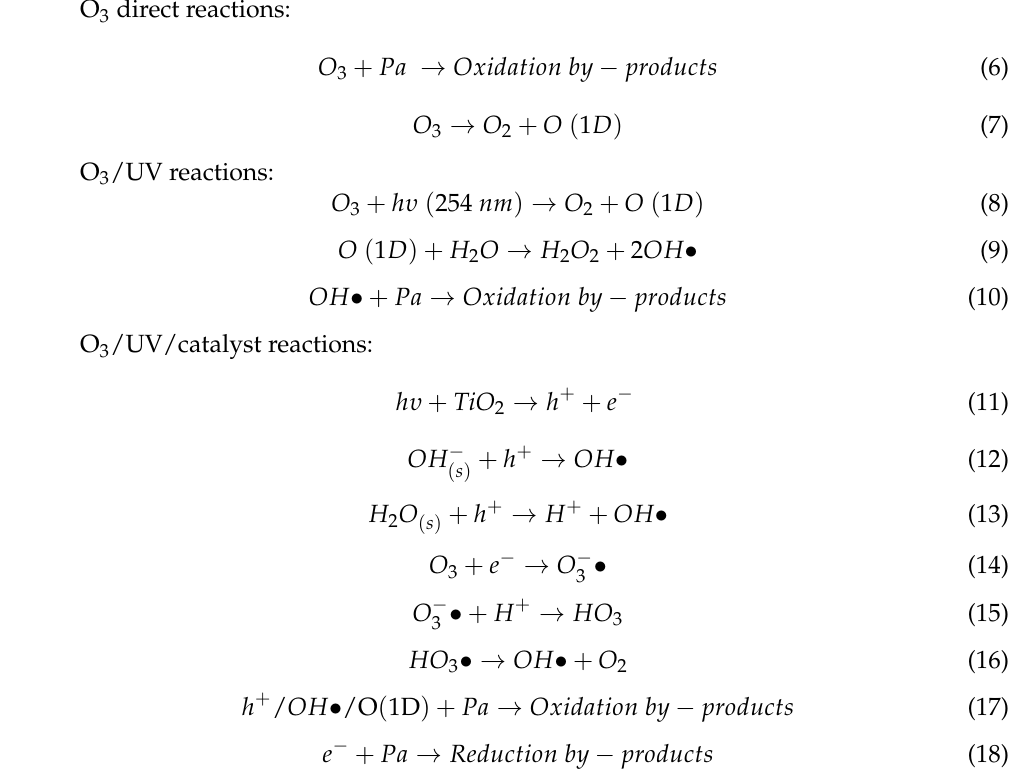
Figure 14. Proposed photocatalytic mechanism for paracetamol oxidation; occurring processes: direct oxidation with ozone ( A ); radical production in the presence of UV radiation ( B ); interactions of formed electrons and holes with O 3 and OH ( C , E ); Ce 3+ /Ce 4+ formation ( D ), NH 3 oxidation ( F ). O 3 direct